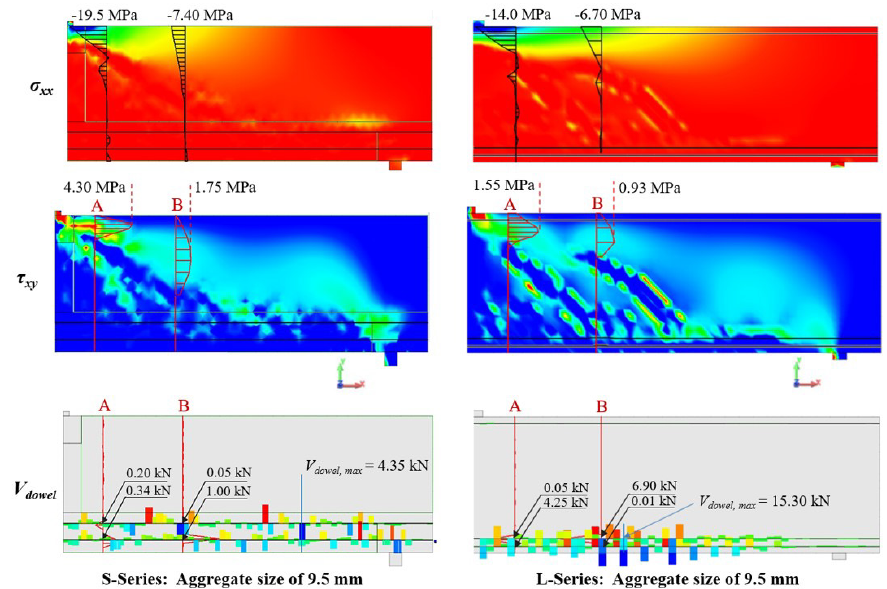
Figure 10. Compression and shear stresses and dowel effect for beams with 9.5 mm size